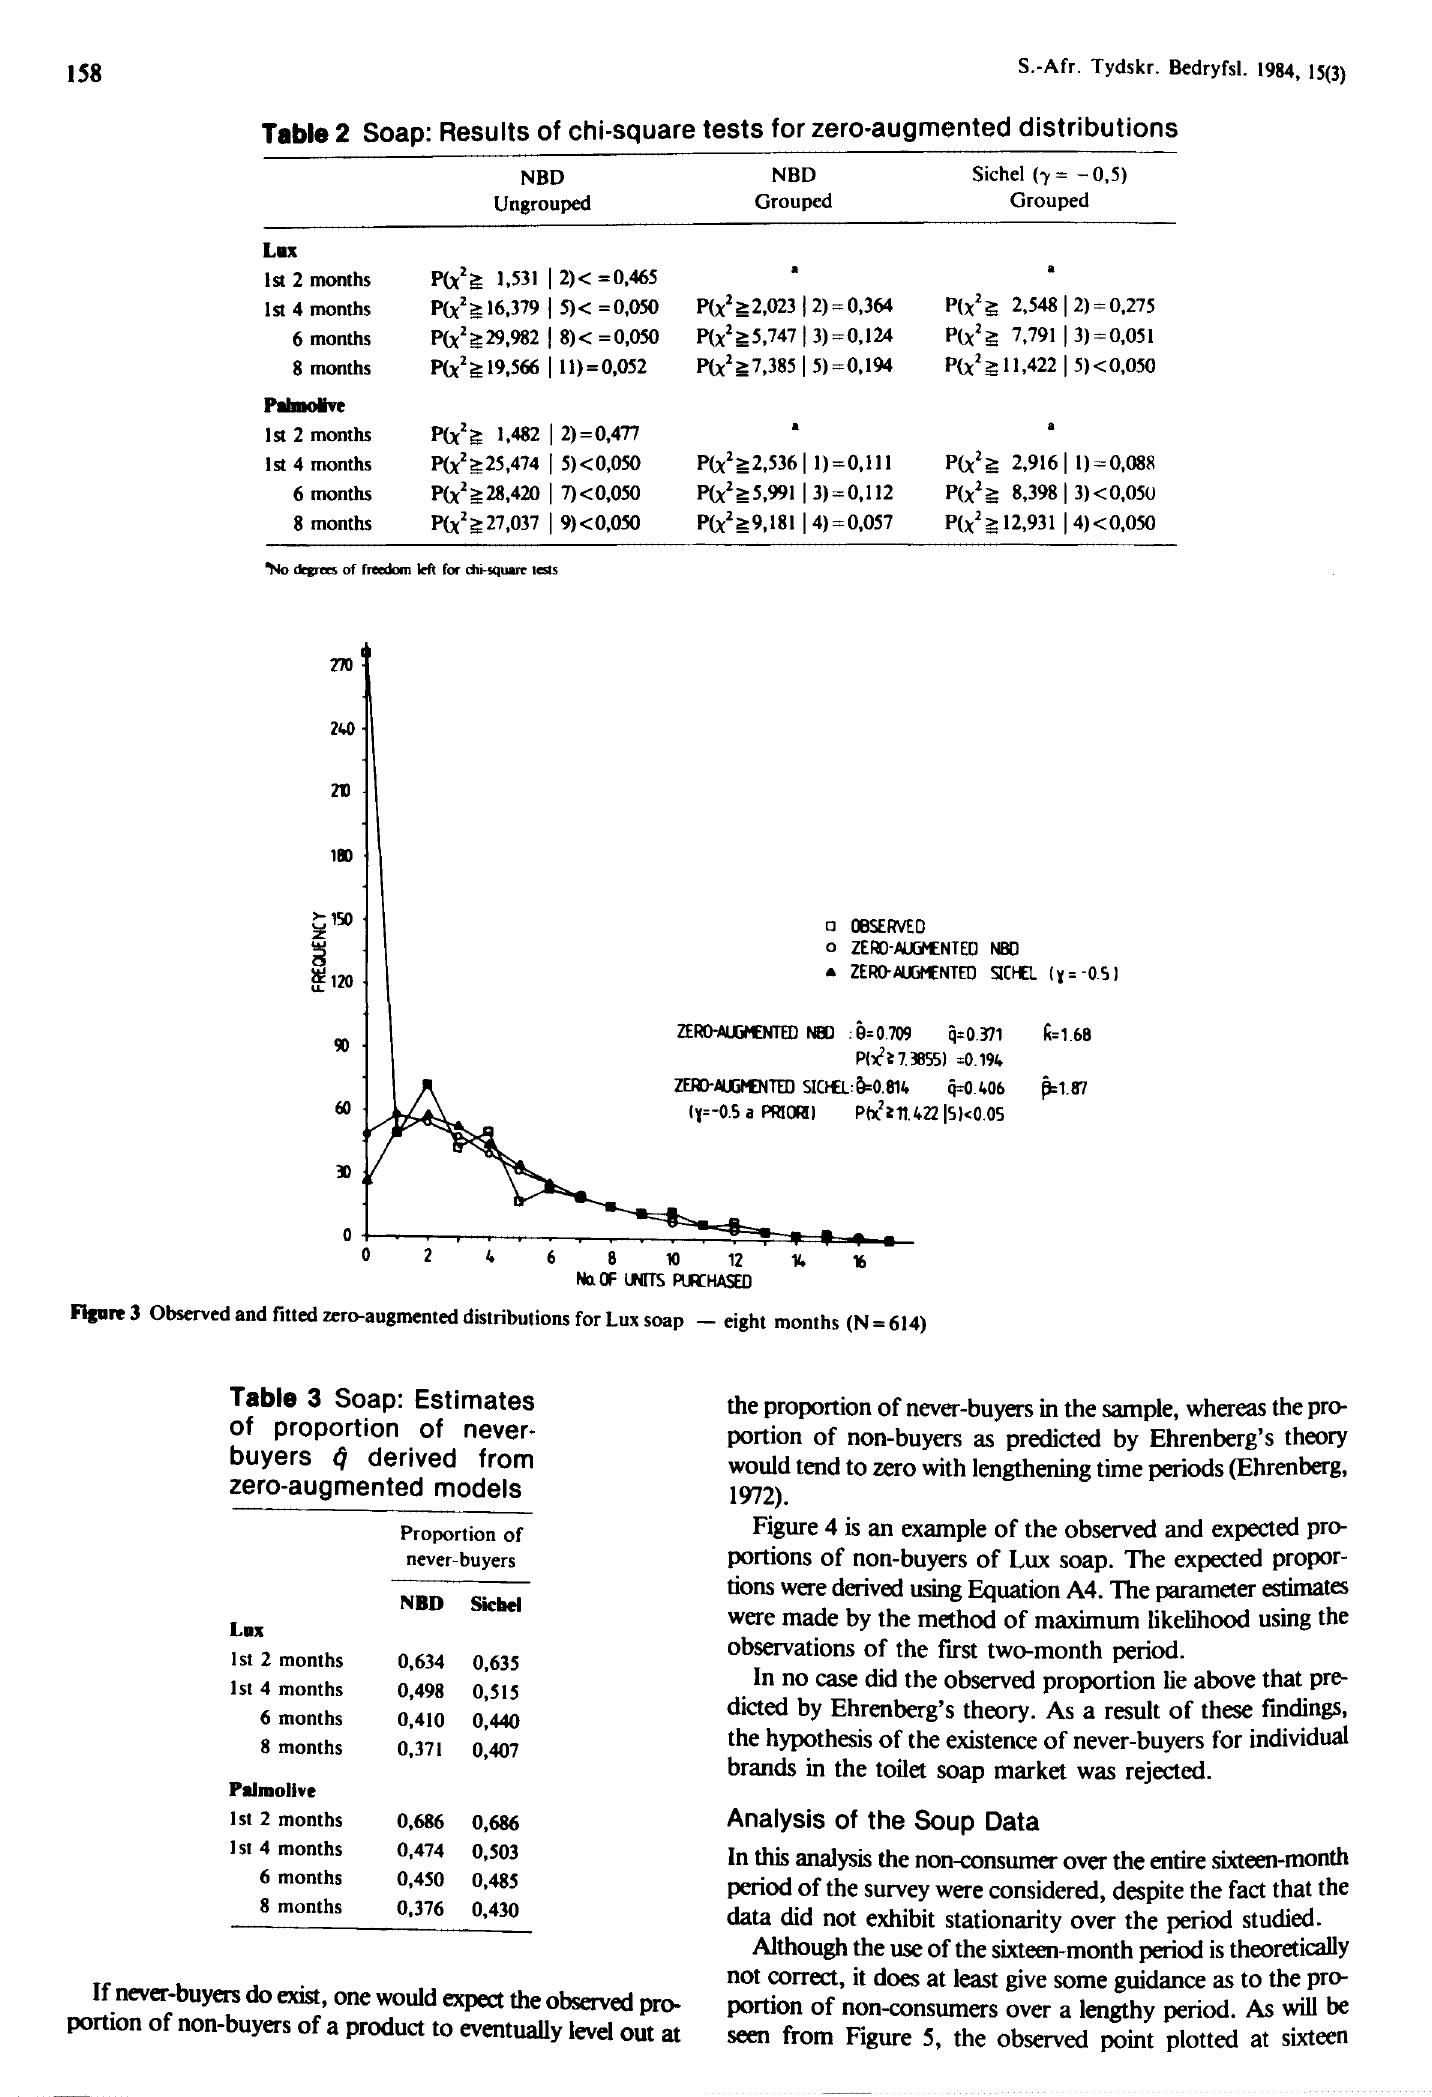
Table 3 Soap: Estimates of proportion of never buyers q derived